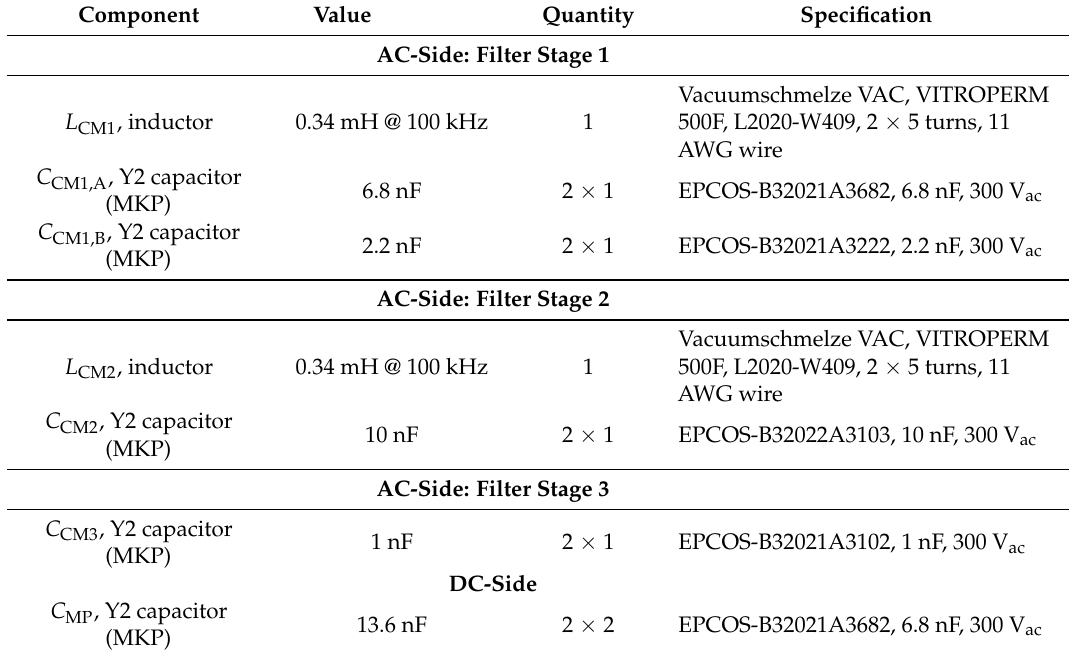
Table A10. Common mode (CM) EMC input filter